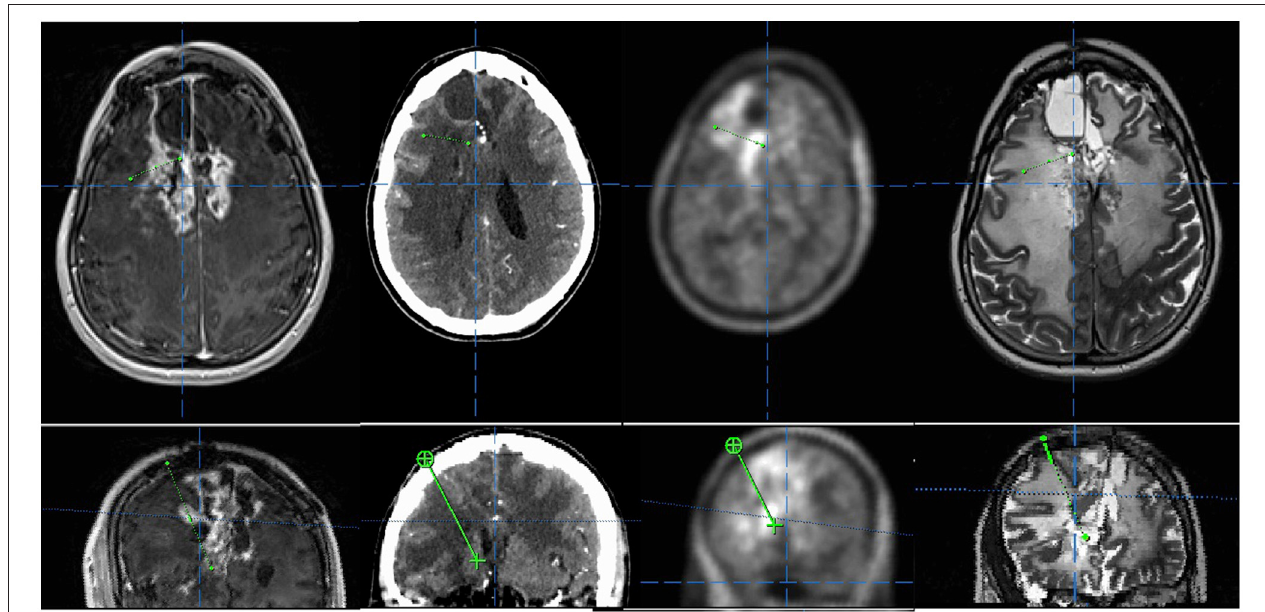
FIGURE 2 | Example of a multimodal trajectory planning targeting both contrast- and (fluorethyl)-L-tyrosine (FET)-enhancing areas in a case of a suspected recurrence of a multimodally treated oligodendroglioma, IDH mutated and 1p/19q co-deleted, the central nervous system (CNS) WHO grade 3. (Upper panel) Axial view of contrast enhanced T1, CT, FET positron emission tomography (PET), and T2. (Lower panel) Inline view depicting the trajectory